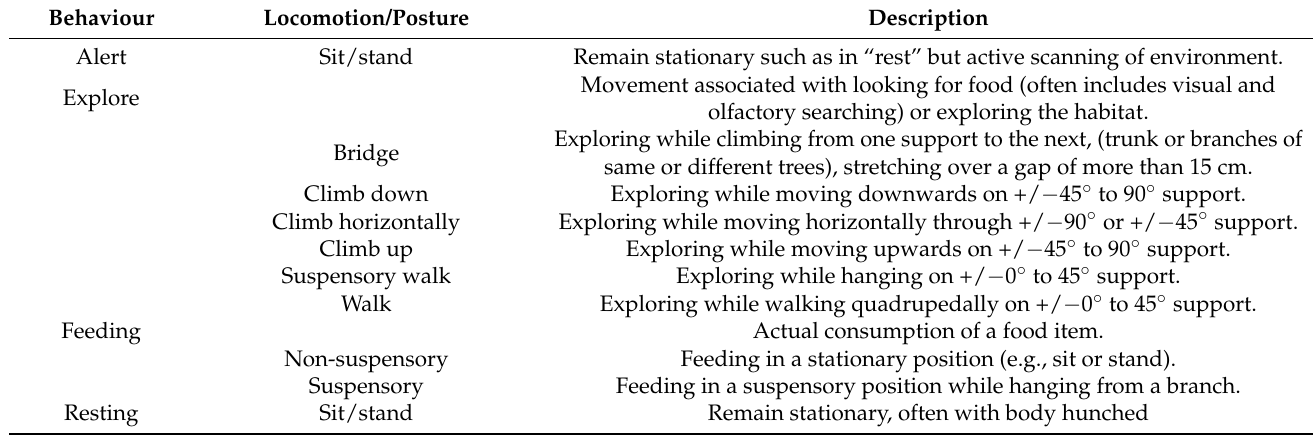
Table 2. Slow loris behavioural ethogram used in this study for video data collection and accelerome- ter